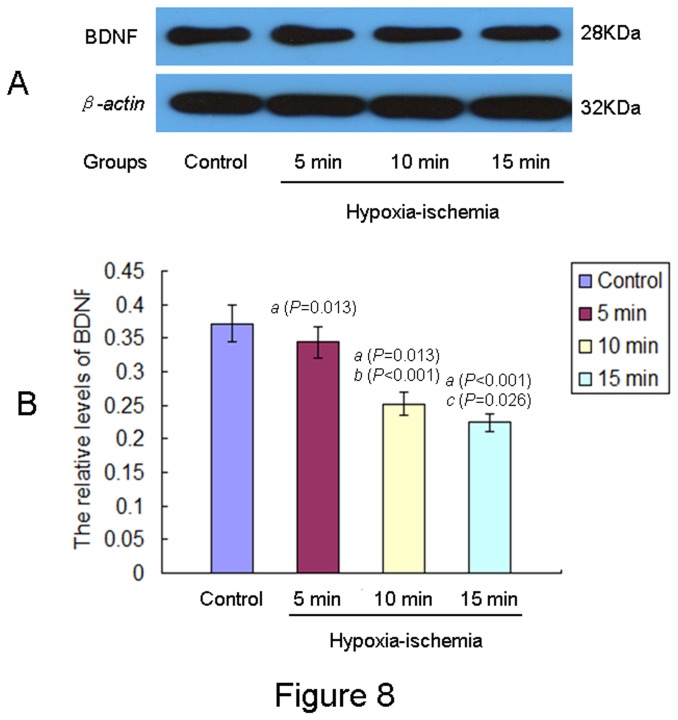
Expression of BDNF in the hippocampal of offspring rats from different groups.
A: A representative Western blot of BDNF protein in the hippocampal of offspring rats from different groups was showed. 
B: Relative levels of BDNF in the hippocampal of offspring rats from different groups (control group, n= 12; 5 min HIE group, n= 13; 10 min HIE group, n= 12; 15 min HIE group, n= 10) at PND 35 were expressed as mean ± S.D.. a: compared with the control group; b: compared with the 5 min HIE group; c: compared with the 10 min HIE group. The P values were showed in the bracket.